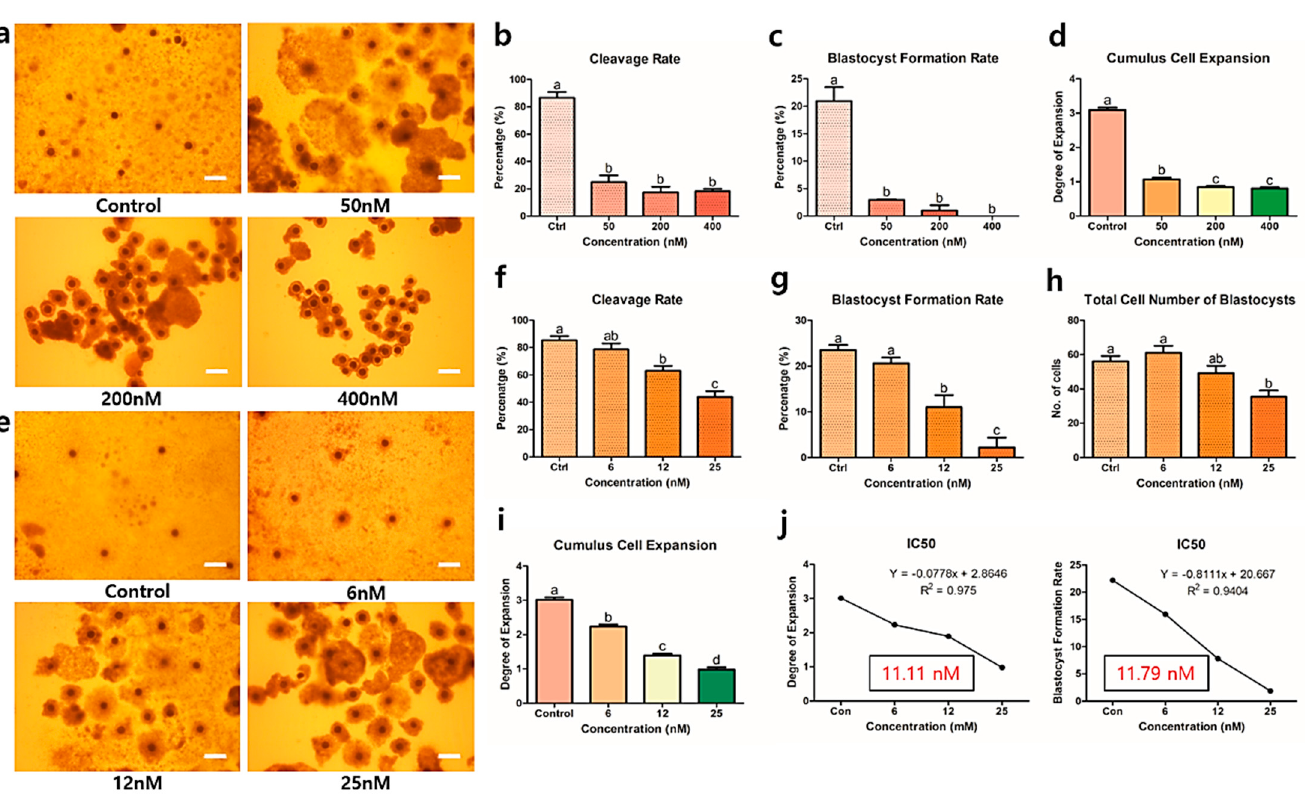
Figure 1. Selection of optimal brusatol concentration via the assessment of embryo development and cumulus expansion. Brusatol concentrations: 0, 50, 200, and 400 nM (first concentration range); 0, 6, 12, and 25 nM (second concentration range). ( a ) Microscopy-based images of cumulus cell expansion in porcine COCs treated with the first concentration range of brusatol are shown; ( b – d ) subsequently, embryo development and CC expansion rates were evaluated. ( e ) A subsequent analysis using the second concentration range of brusatol was performed. Acceptable results were observed for ( f ) cleavage rate, ( g ) blastocyst formation rate, ( h ) total cell number, and ( i ) CC expansion. ( j ) Lastly, the selected brusatol concentration (12 nM) was confirmed by calculating the IC 50 (11.11 and 11.79 nM, respectively). Bars with letters indicate significant di ff erences ( p < 0.05). Original magnification: 20 × ; bars indicate 300 µ m. Ctrl or Con: control. At least five replicates were performed for each experiment.